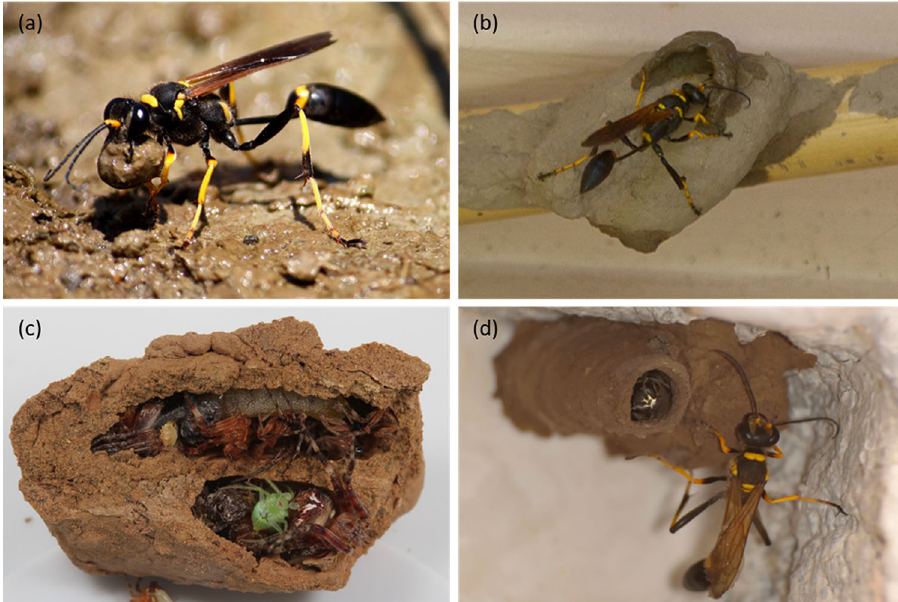
Figure 1. Nest construction process of black and yellow mud dauber: ( a ) a mud dauber collects and forms soil into a soil ball and ( b ) plasters the soil ball on the nest; ( c ) nest cells are provisioned with spiders; and ( d ) a mud dauber closes the opening of the cell using collected soil. ( a ): photo courtesy of an author named Hglu1 via https:// en. wikip edia. org/ wiki/ Sceli phron_ caeme ntari um#/ media/ File: 20100 710. MudDa uber- Sceli phron Caeme ntari um. Hanni bal. jpg. The photo is licensed under a Creative Commons Attribution-ShareAlike 3.0 Unported license. The license terms can be found on the following link: https:// creat iveco mmons. org/ licen ses/ by- sa/3. 0/ deed. en. ( b ), ( c ), and ( d ): photo courtesy of authors named mnwild, Patrick Coin, and Ricardo Arredondo T. via https:// www. inatu ralist. org/ obser vatio ns/ 39302 921, https:// www. inatu ralist. org/ obser vatio ns/ 84198 59, and https:// www. inatu ralist. org/ obser vatio ns/ 10717 949. These photos are licensed under a Creative Commons Attribution-NonCommercial 4.0 International license. The license terms can be found on the following link: https:// creat iveco mmons. org/ licen ses/ by- nc/4.